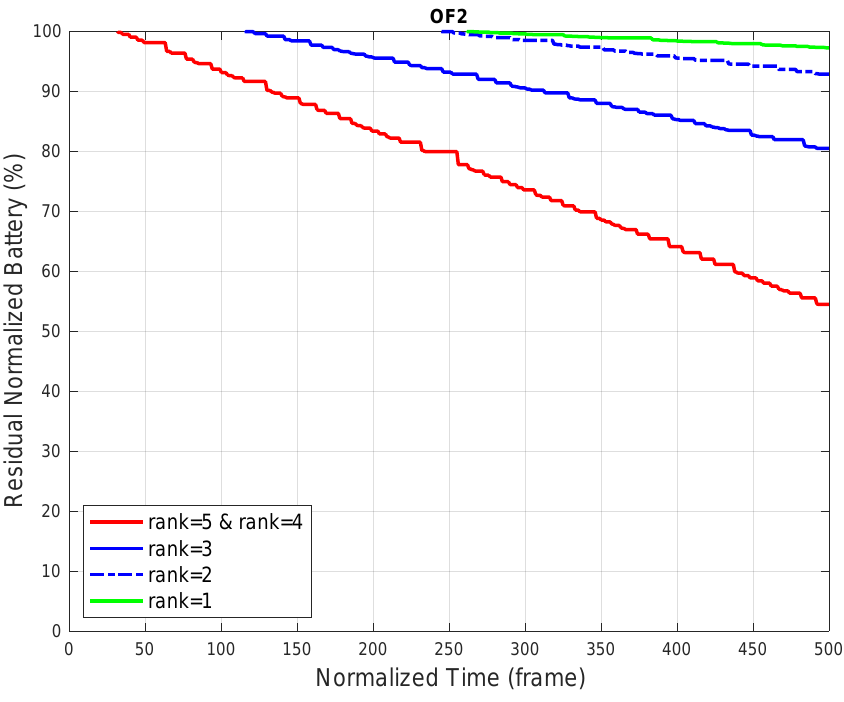
Figure 5. Residual normalized battery level time evolution of different groups of devices connected with RPL